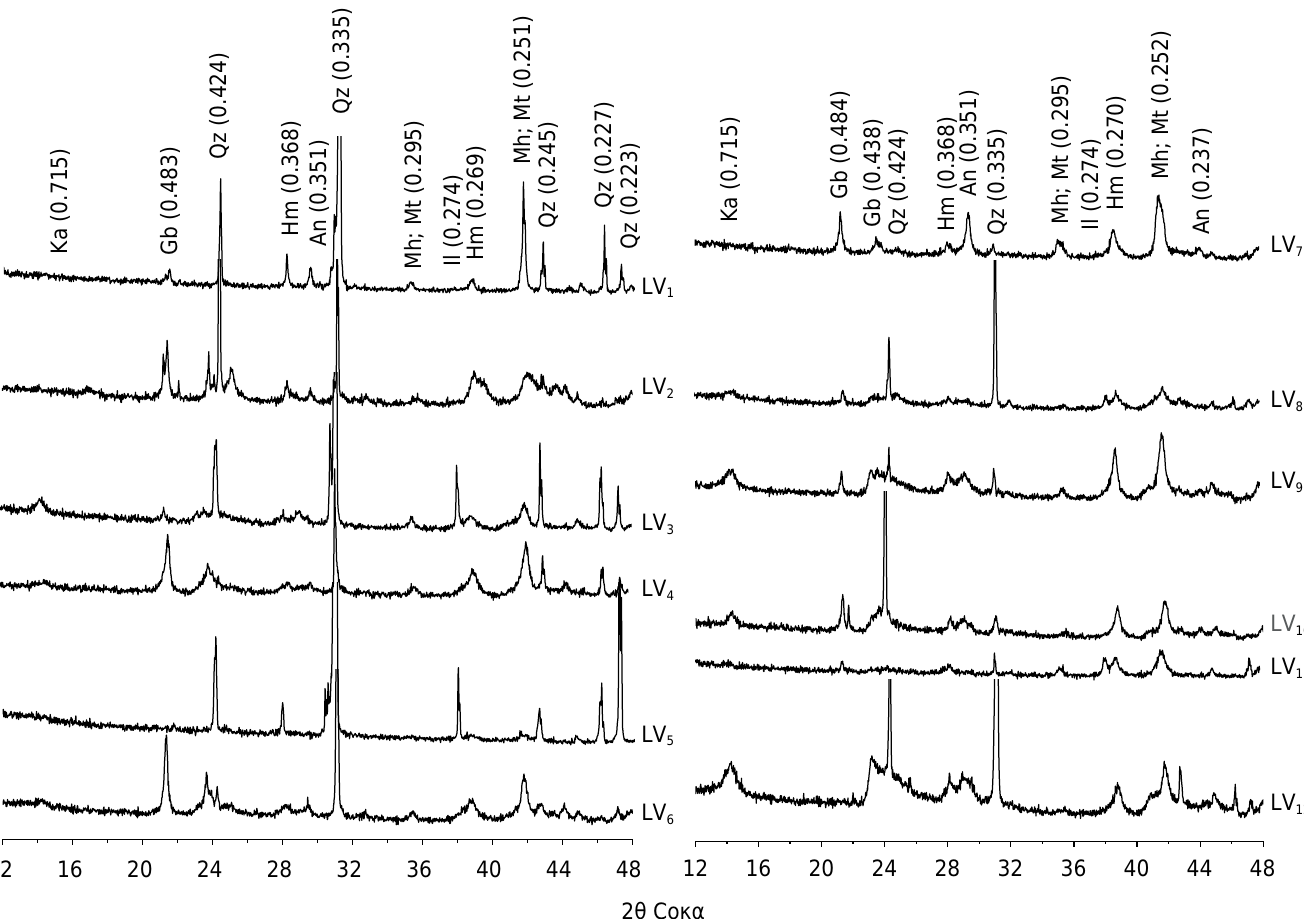
Figure 2. X-ray patterns from sand fraction (powder method) of the soils. Ka: kaolinite; Gb: gibbsite; Qz: quartz; An: anatase; Hm: hematite; Mh: maghemite; Mt: magnetite; and Il: ilmenite. Numbers between parentheses correspond to distance between adjacent planes in nanometers (nm) expressed in three decimal places. LV 1 , LV 3 , LV 4 , LV 5 , LV 6 , LV 8 , LV 9 , LV 10 , and LV 11 : Rhodic Hapludox; LV 2 ,